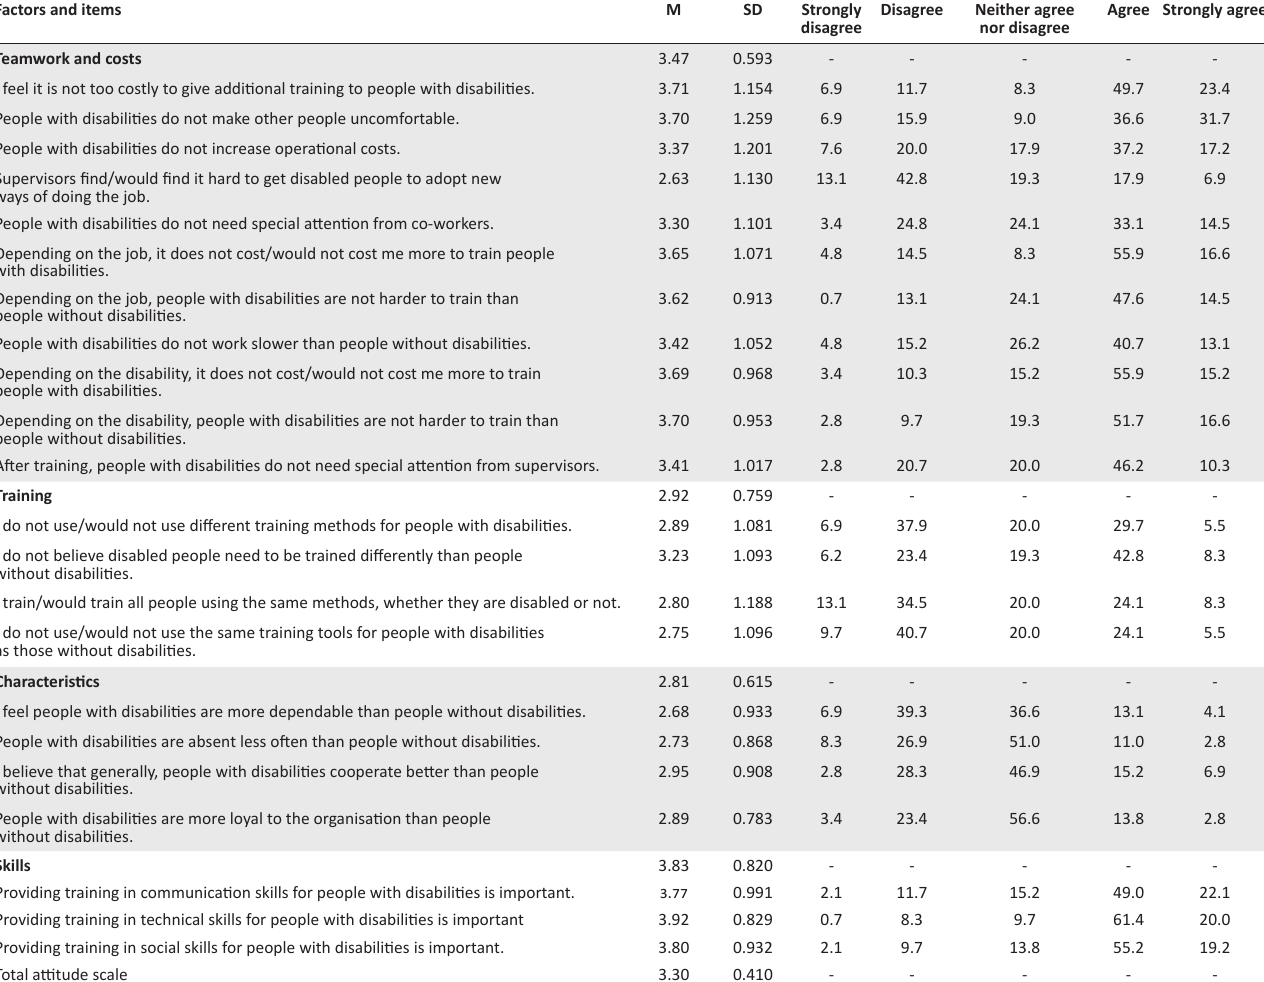
TABLE 3: Public sector managers’ mean scores for the items and factors of the attitudes towards people with disabilities scale. Factors and items M SD